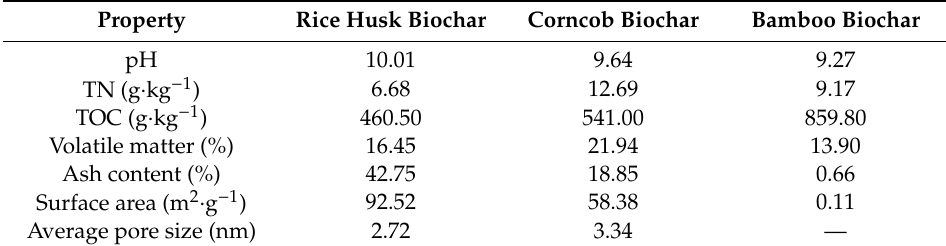
Table 1. The physico-chemical properties of biochars from different raw materials. Property